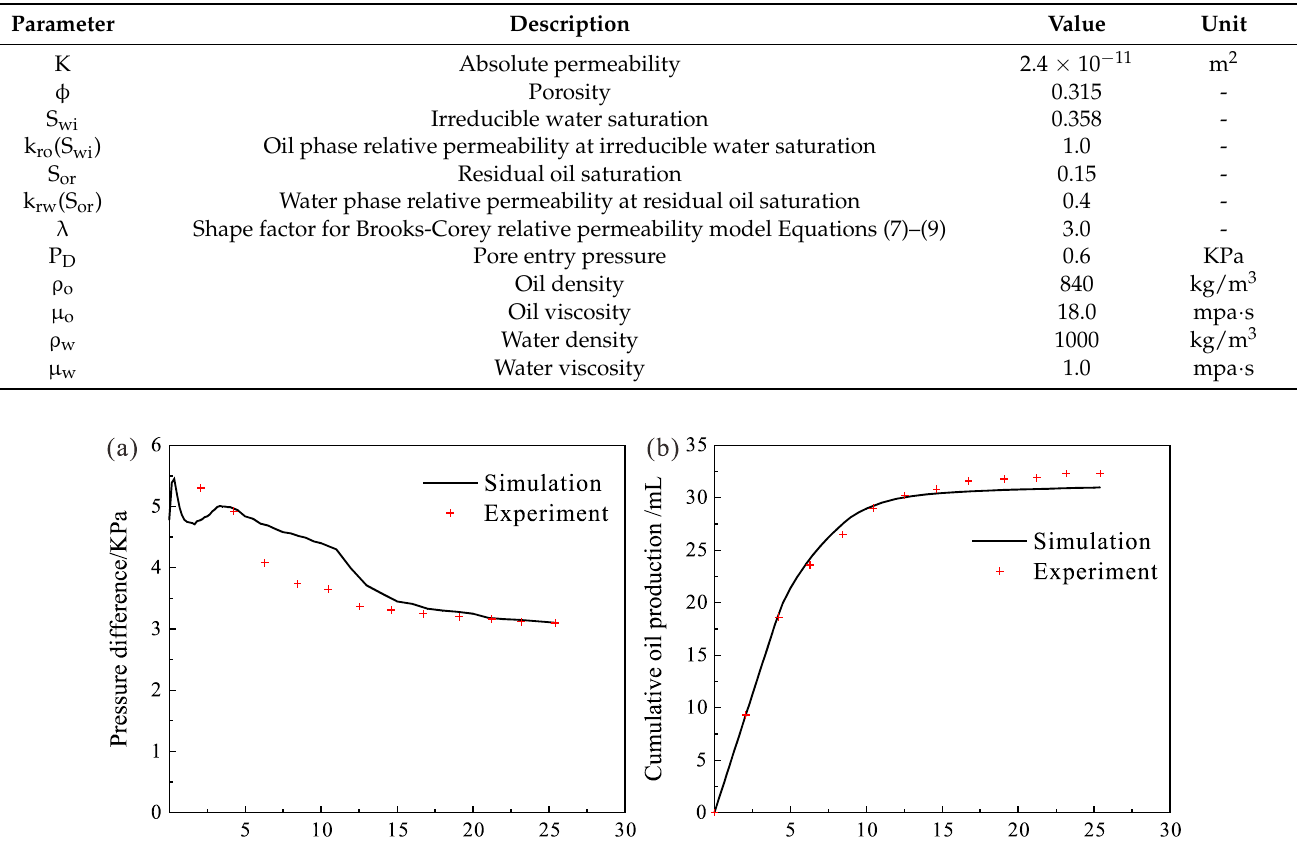
Table 1. Parameters for the simulation of experiment Case 2.